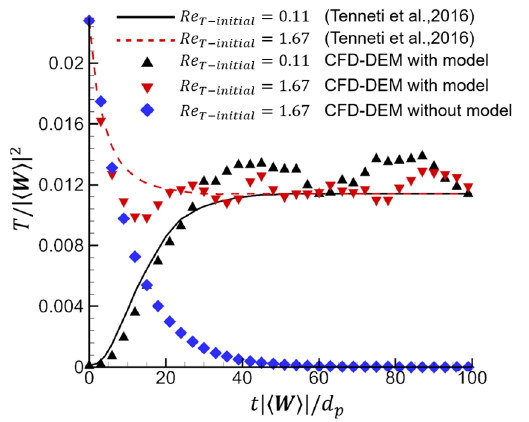
Figure 3. Evolution of granular temperature predicted by CFD-DEM simulations with the proposed model under different initial granular temperatures. Re T − initial is the initial granular temperature-based Reynolds number imposed on the particles. For details of imposing initial granular temperature on the particles, please refer to Huang et al. [13]. It should be noted that the scatters from CFD-DEM without the new model for Re T − initial = 0.11 are not shown, as the corresponding granular temperatures were too small.